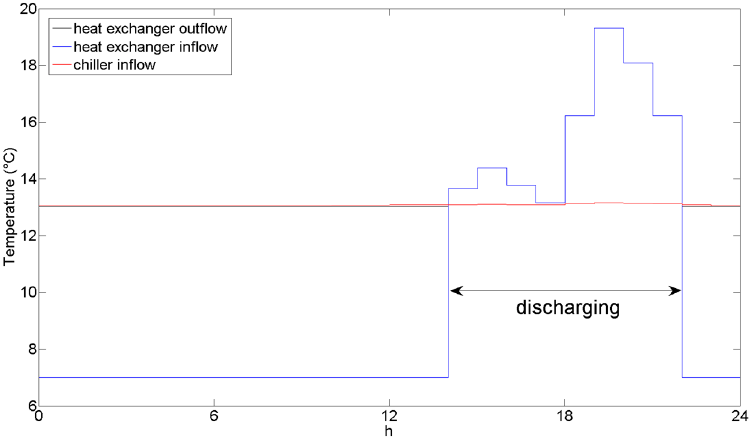
Figure 15. HTF temperature profiles at the PCM tank heat exchanger inflow and outflow sections, and at the chiller inflow section.